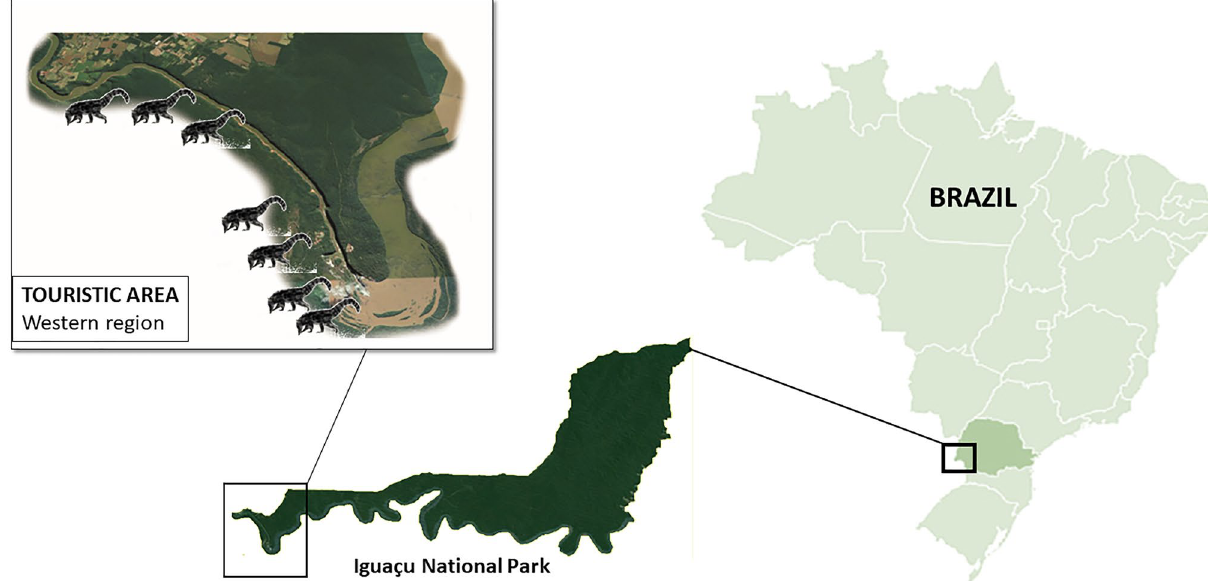
Figure 1. Map showing Paraná State (light green) and Iguaçu National Park (dark